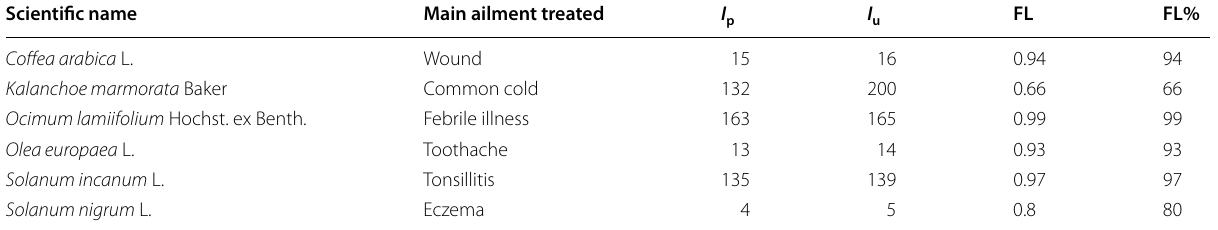
Table 4 Fidelity level of six medicinal plant species Scientific name